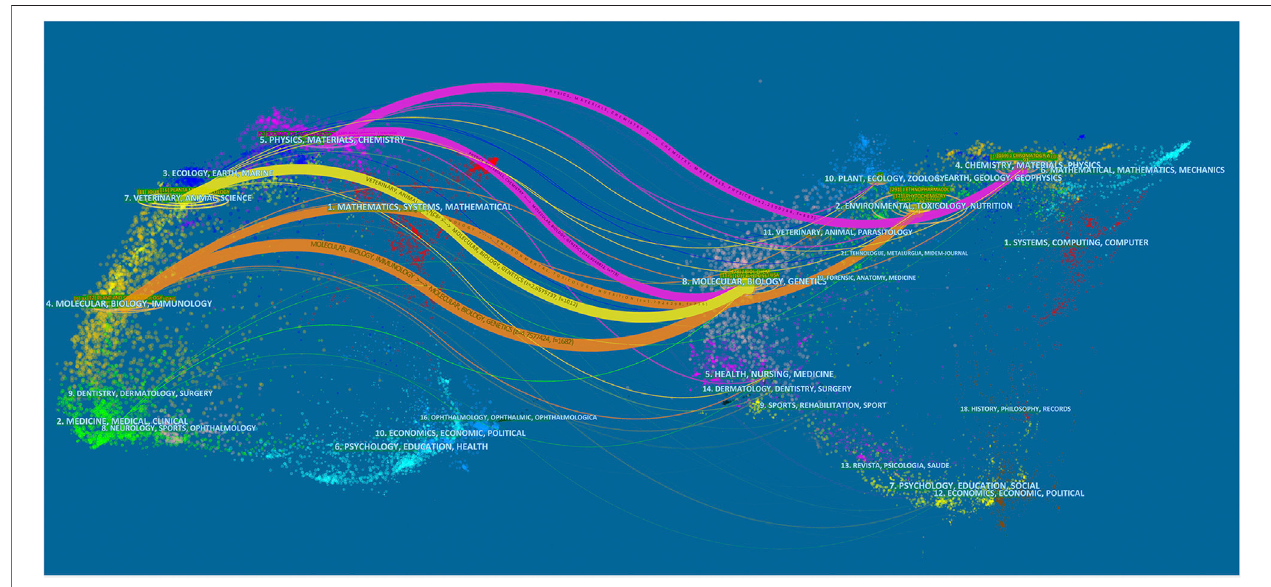
FIGURE 2 | The dual-map overlay of